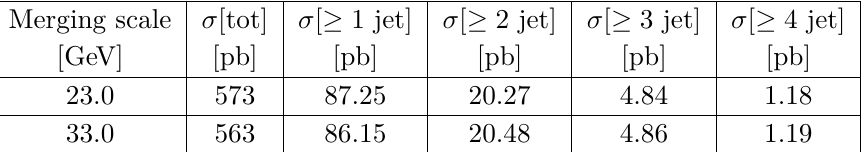
Figure 20 . TMD merging systematic uncertainty at the LHC at momentum (right) and normalized φ ∗ (left) distributions of Drell-Yan lepton pairs are calculated for three different values of the merging scale, where the solid line represents the default